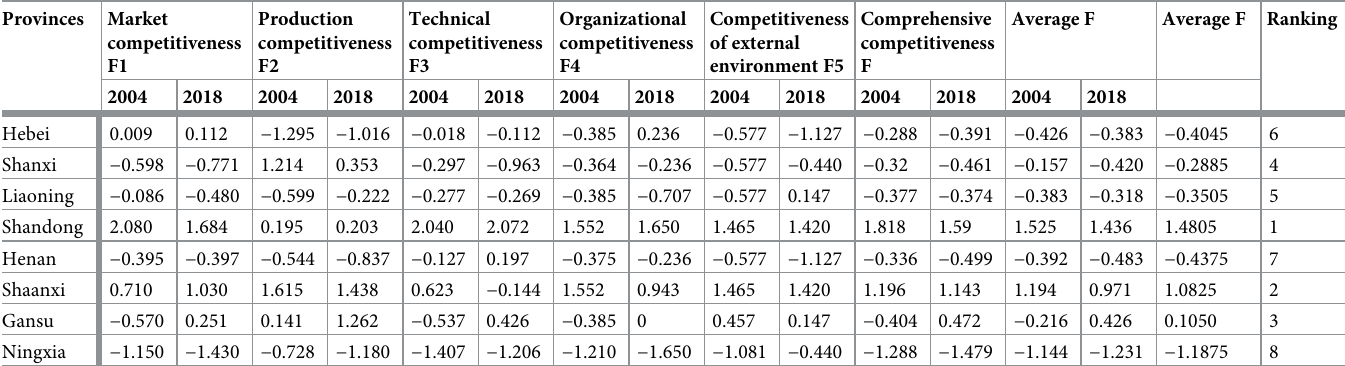
Table 2. Overall competitiveness rankings.